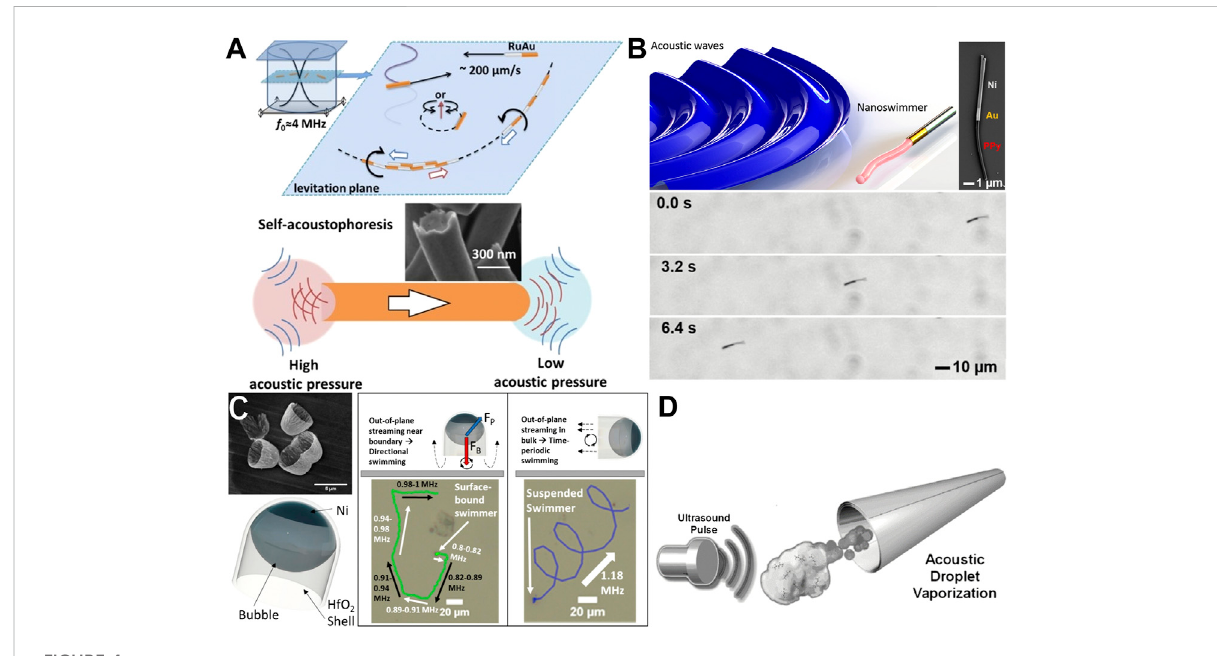
FIGURE 4 Examples of acoustically powered microrobots. (A) Asymmetric metallic rods propelled by self-acoustophoresis. Reprinted with permission (Wang et al., 2012). Copyright 2012 American Chemical Society. (B) Bimetallic rods propelled by acoustically activated fl agella. Reproduced with permission (Ahmed et al., 2016a). Copyright 2016 American Chemical Society. (C) SEM image and schematic of cup-shaped swimmers along with different propulsion behavior at different acoustic frequencies. Reproduced with permission (McNeill et al., 2020). Copyright 2020 American Chemical Society. (D) Metallic microtubes propelled by acoustically vaporized bubbles of per fl uorocarbon. Reproduced with permission (Kagan et al., 2012). Copyright 2012